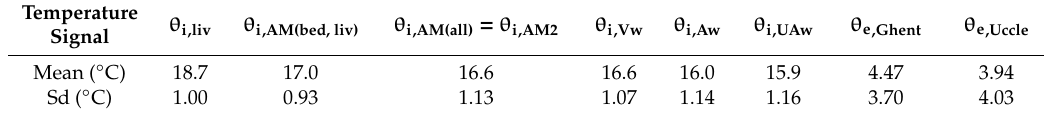
Table 6. Mean and standard deviation (Sd) of the interior temperature signals tested in packages 2–4 over the training period. Figures are based on the six-hourly values that are used as input for the ARX